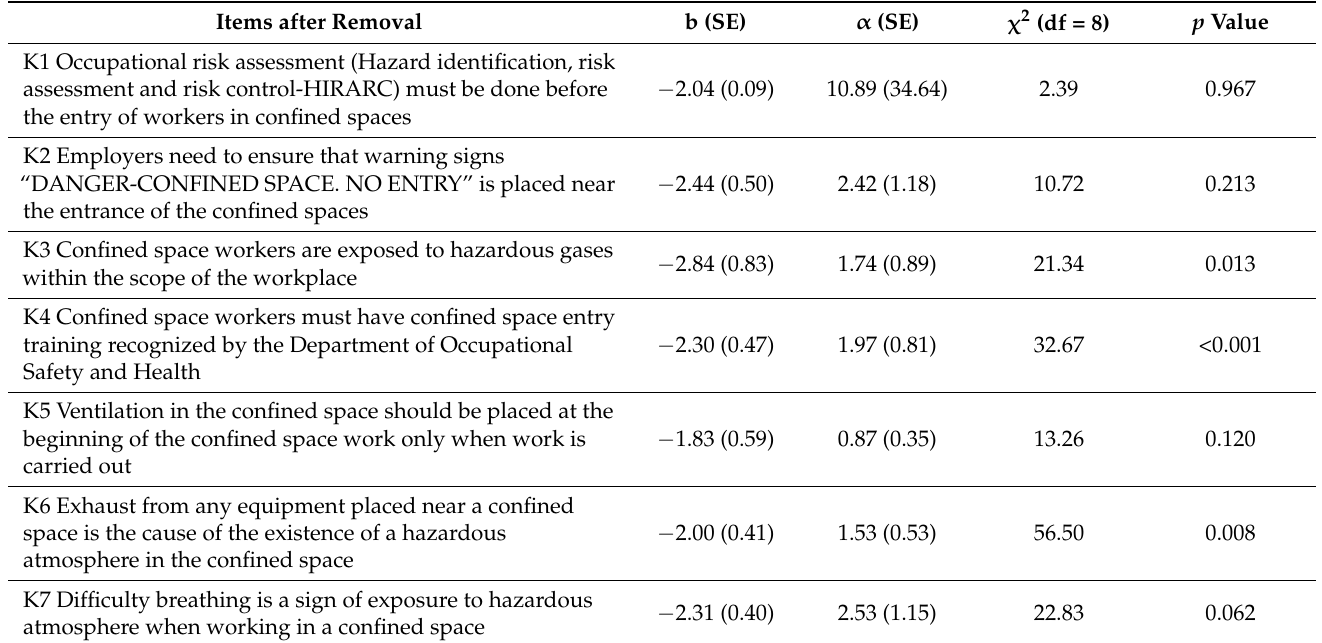
Table 3. Result of the IRT analysis in the knowledge section in validation study ( n =